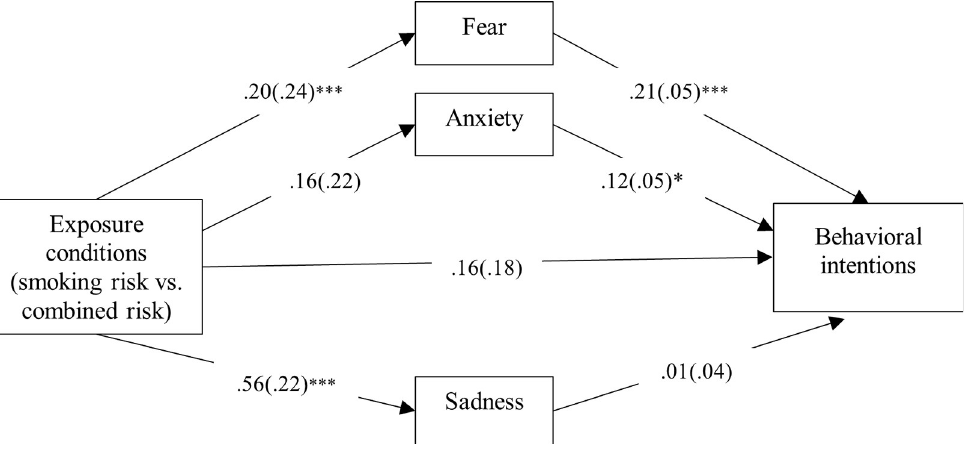
Fig 1. Indirect effects of exposure to news stories on behavioral intentions. � p < .05; ��� p <